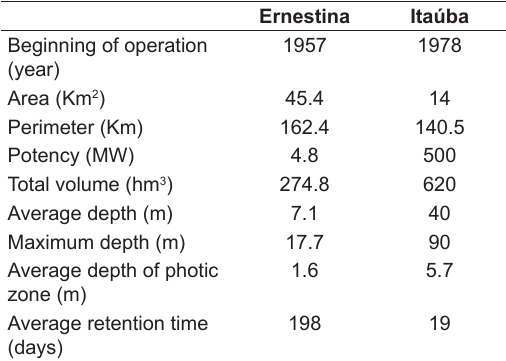
Table 1. Description of Ernestina and Itaúba reservoirs and respective hydroelectric power stations, located in the upper course of the River Jacuí, Rio Grande do Sul, Brazil.